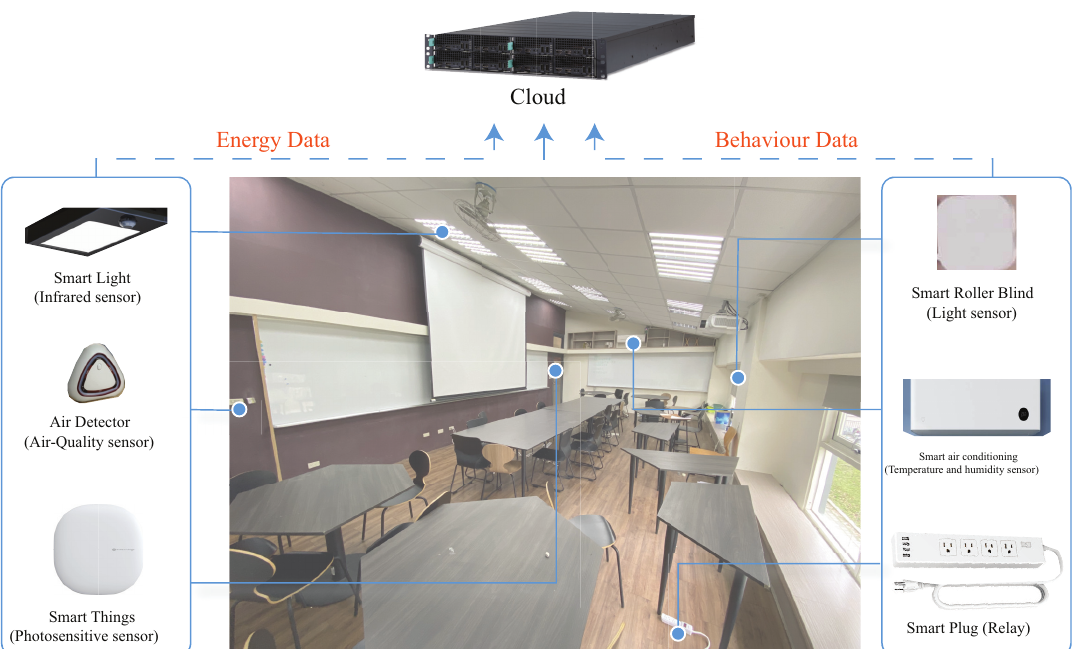
Figure 8. A hybrid Internet of Things (IoT) model of behavior/Energy data layers.